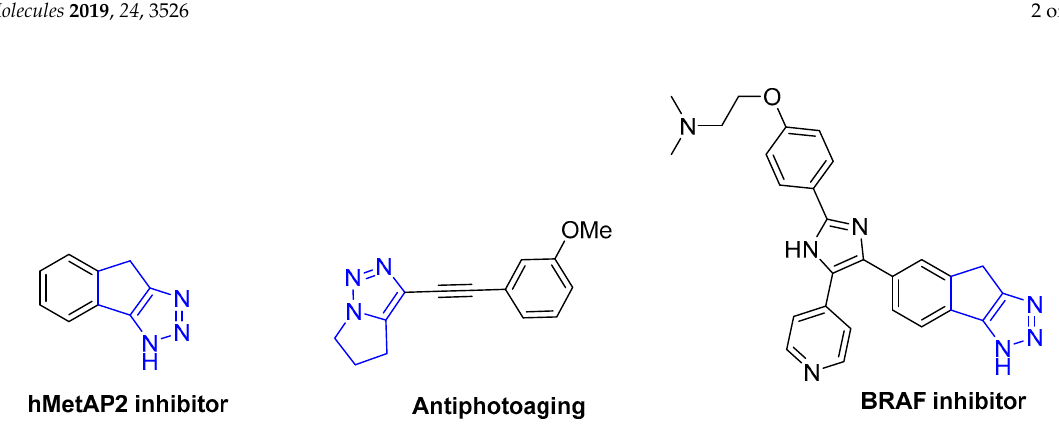
Figure 1. Representative molecules of bioactive fused 1,2,3 – triazoles.